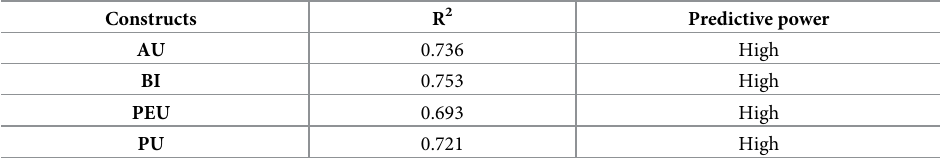
Table 8. R 2 of the endogenous latent variables.